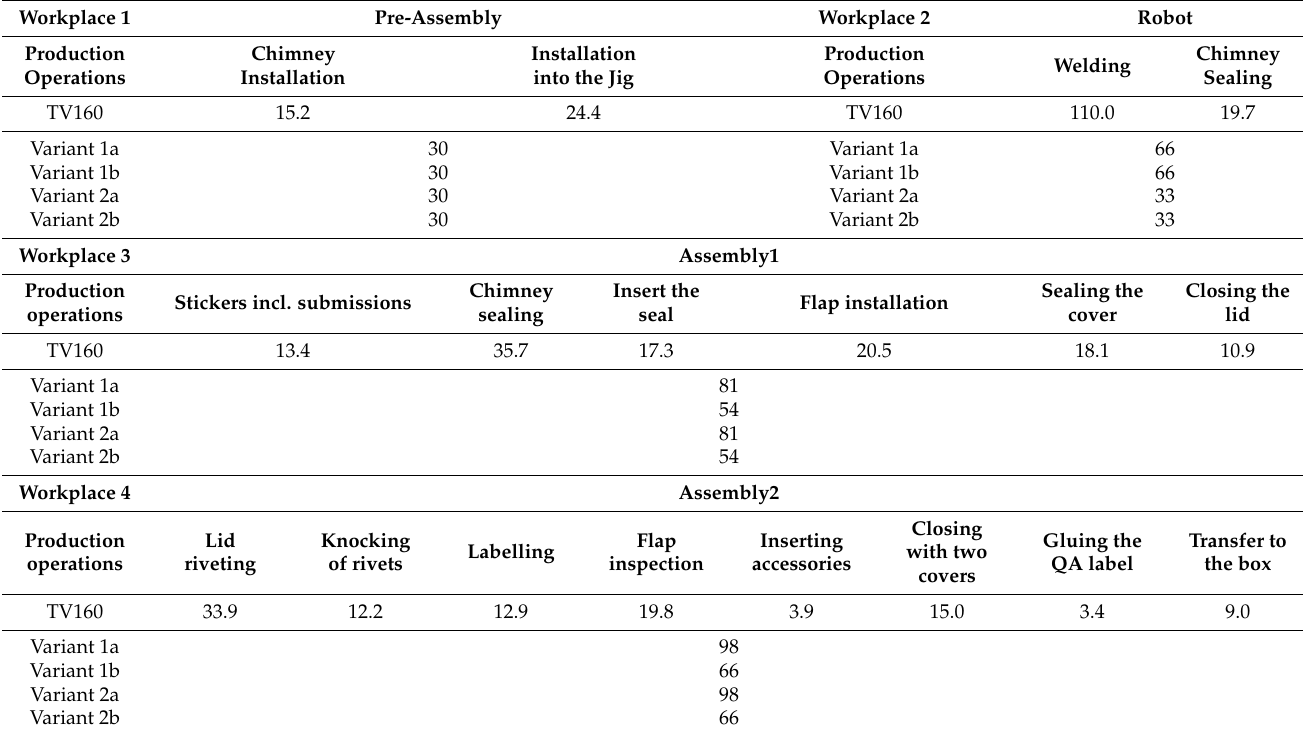
Table 2. Proposed state of production—workplaces, production operations, and total times at workplaces in